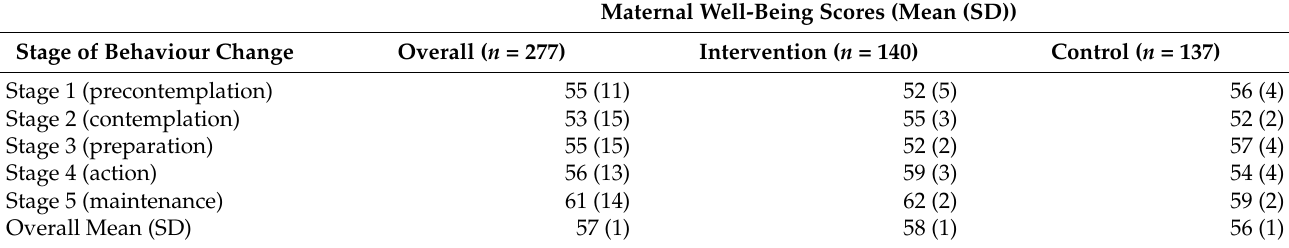
Table 2. Baseline maternal well-being scores * at each stage of behaviour change. Values reported are mean percentage scores (standard deviation;